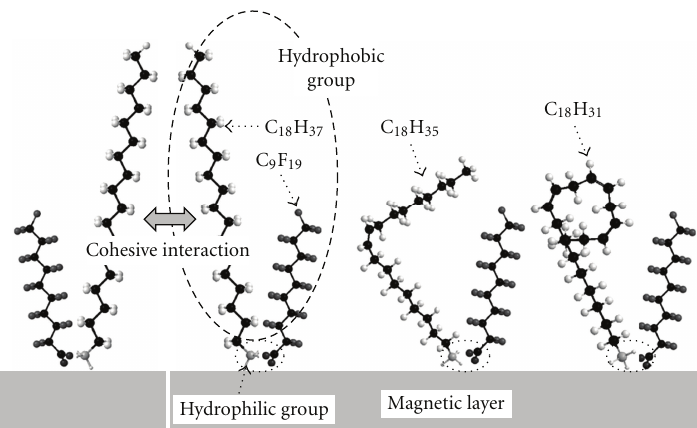
Figure 12: A model for the salt type lubricants adsorbed on the carbon layer.